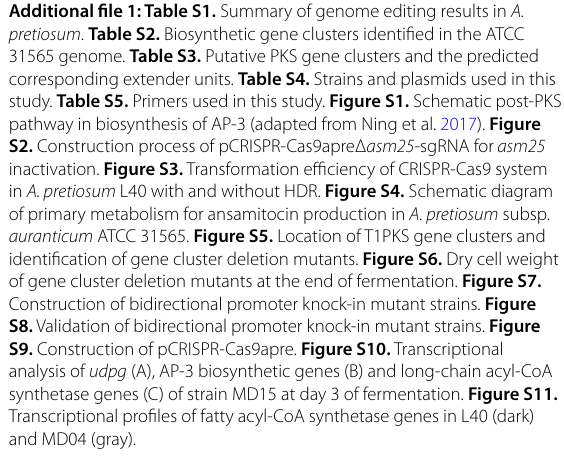
study. Table S5. Primers used in this study. Figure S1. Schematic post-PKS pathway in biosynthesis of AP-3 (adapted from Ning et al. 2017).